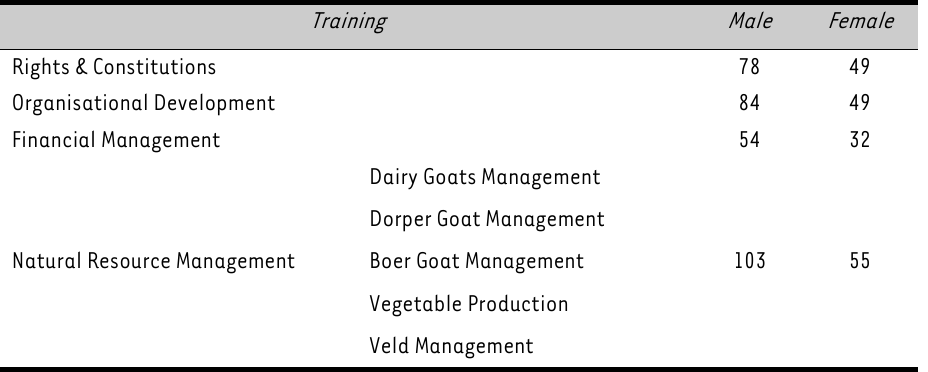
TABLE 2: Number of beneficiaries of training modules,